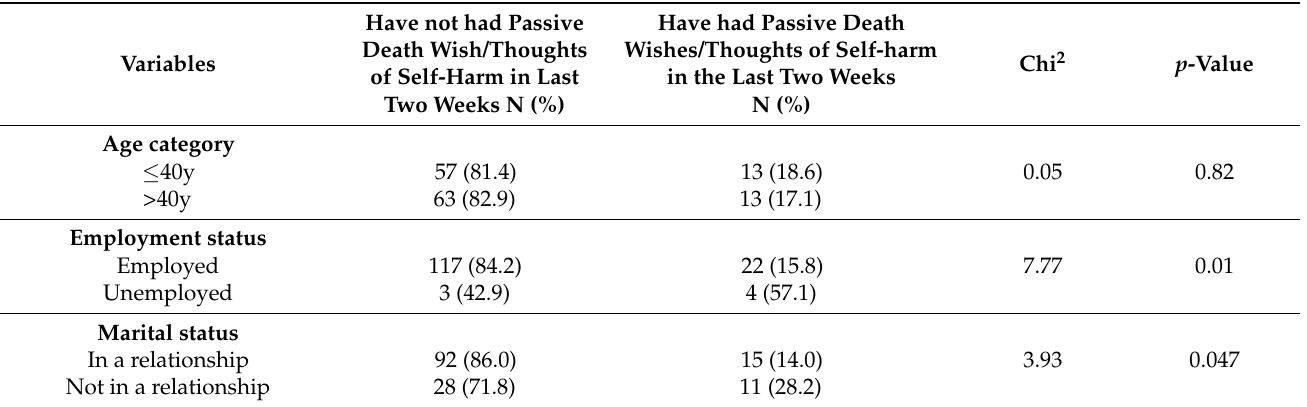
Table 2. Chi-squared association between the demographic and clinical variables and the likelihood of experiencing passive death wishes or thoughts of self-harm in the preceding two